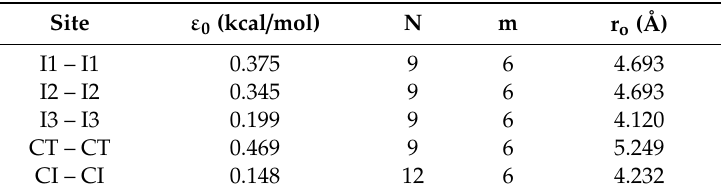
Table 2. Ionic Liquid [bmim][Cl] Mie potential parameters.